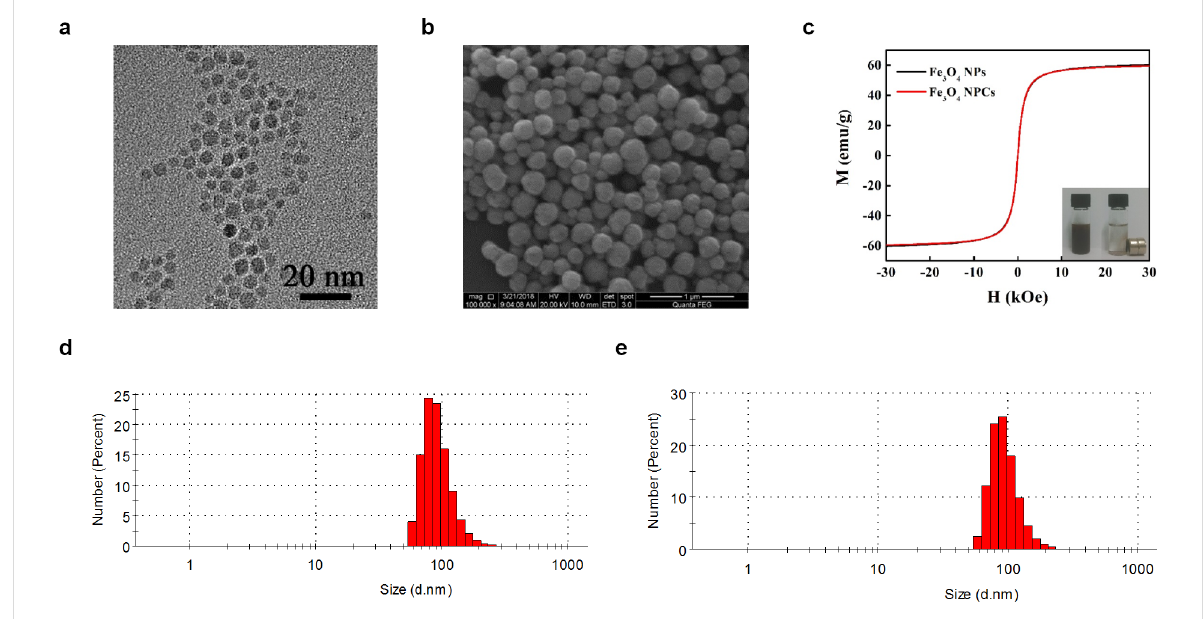
Figure 1: Characterization of the superparamagnetic Fe 3 O 4 nanoparticle clusters. (a) TEM image revealing cubic morphology of individual Fe 3 O 4 nanoparticles with a uniform diameter of ca. 5.2 nm. Scale bar: 20 nm. (b) SEM image of clustered Fe 3 O 4 nanoparticles with an average diameter of 329.2 nm. Scale bar: 1 µm. (c) Magnetic hysteresis curves of individual Fe 3 O 4 nanoparticles as well as NPCs. The insert shows aggregation of NPCs dispersed in aqueous solution by a magnet. (d) DLS characterization of NPCs dispersed in cell culture medium. (e) DLS results of NPCs suspension after five heating/cooling cycles.